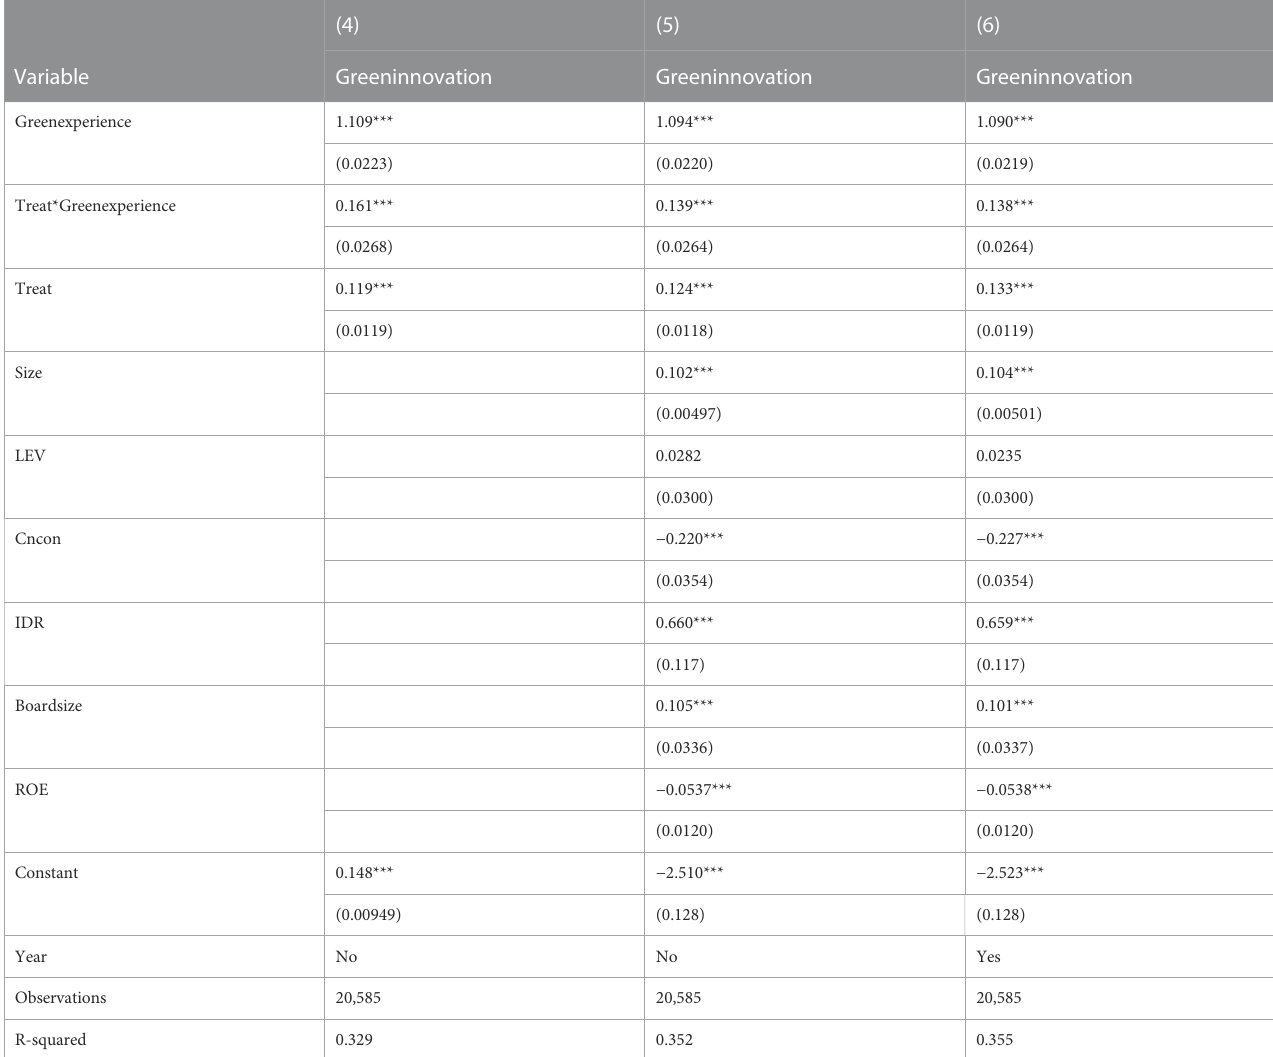
TABLE 5 Moderating effects of tax credit ratings on CEO ’ s green ecological experience and green